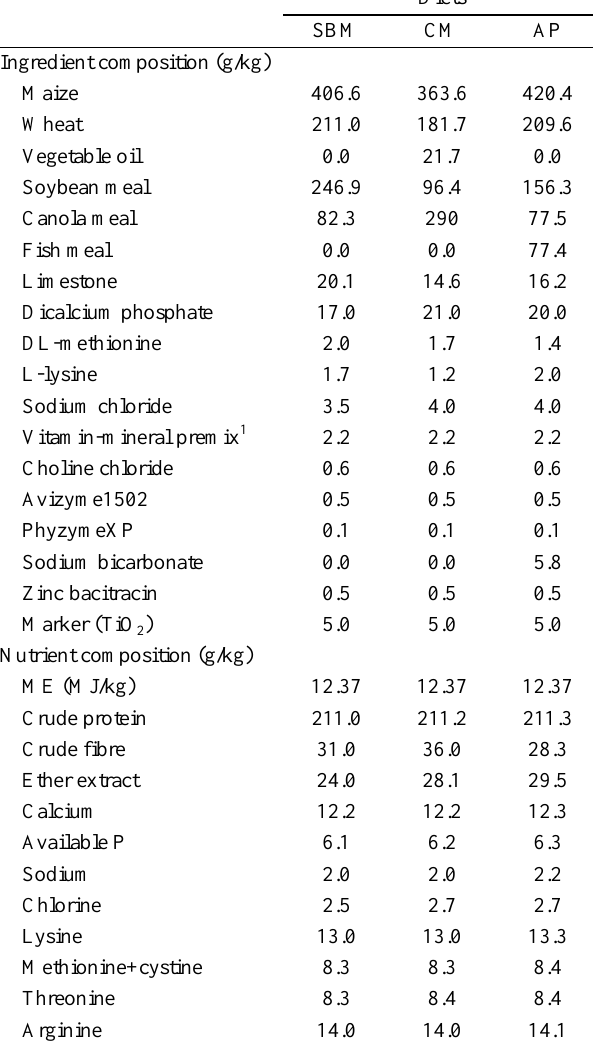
Table 2. Composition of diets fed the